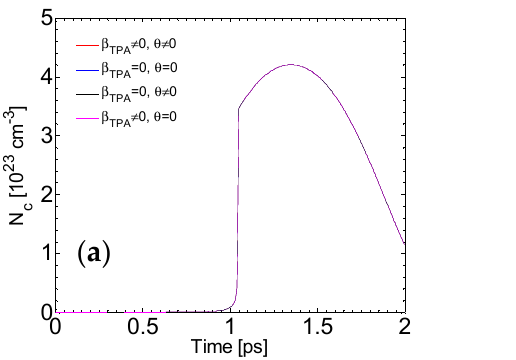
Figure A2. Simulation results of maximum carrier density ( a ) and carrier temperature ( b ) for t delay = 0 ps, E p = 50 mJ/cm 2 for (100) TiO 2 .